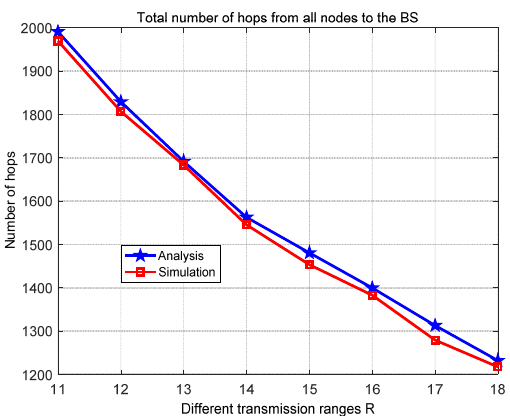
Figure 5. Calculation of total number of hops from all sensors to the Base-Station when the transmission range R is increased from 11 to 18 [units]